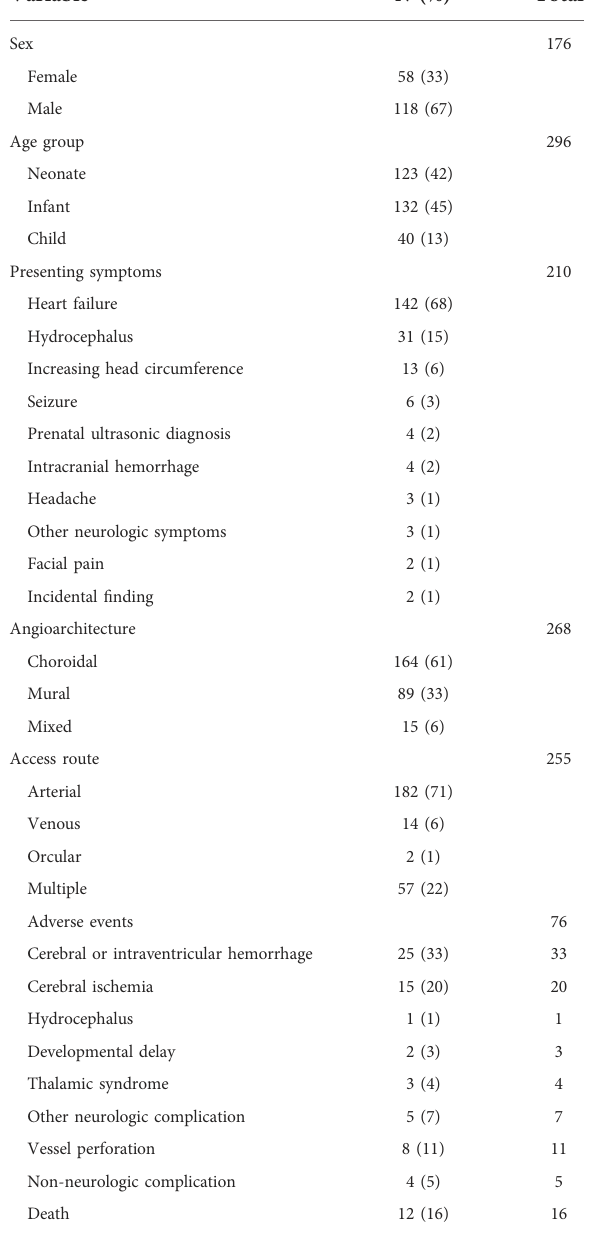
TABLE 1 Patient characteristics and adverse events.